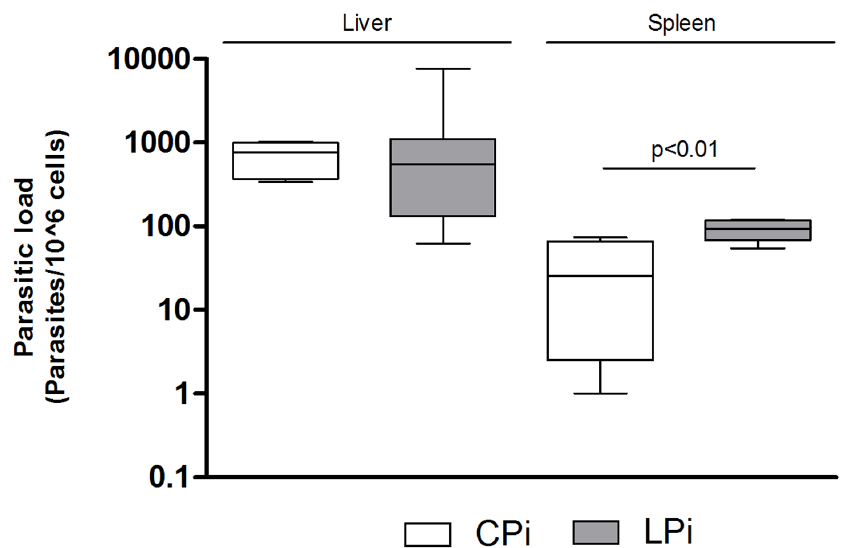
Fig. 3. Splenic and liver parasite load in mice infected with L. infantum . The parasite load was determined by qPCR in liver and spleen. The number of parasites was calculated in relation to 10 6 cells. Data represent the mean of 8–10 animals in each group. Statistical differences were analyzed by Student’s t test (p , 0.01). CPi: animals fed 14% protein diet and infected; LPi: animals fed 4% protein diet and infected.